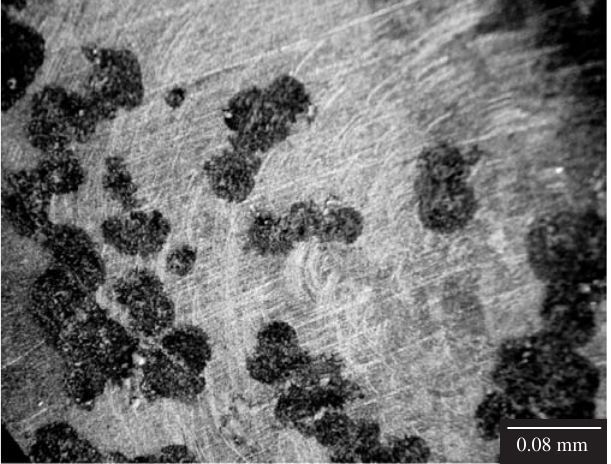
Figure 3. Microphotograph of the magnesium surface after performing the polarization curve in NaCl solution (0 x